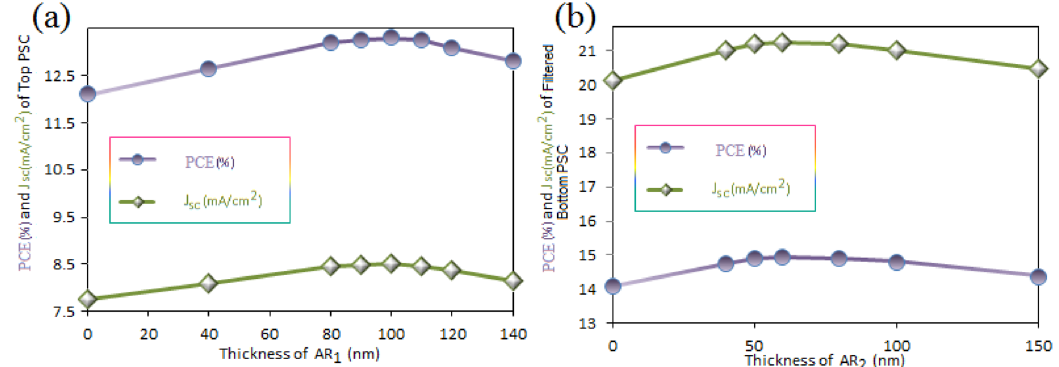
Figure 7. ( a ) Impact of ARL 1 thickness on J sc and PCE parameters of the top sub cell. ( b ) The effect of ARL 2 thickness on J sc and PCE parameters of the bottom sub